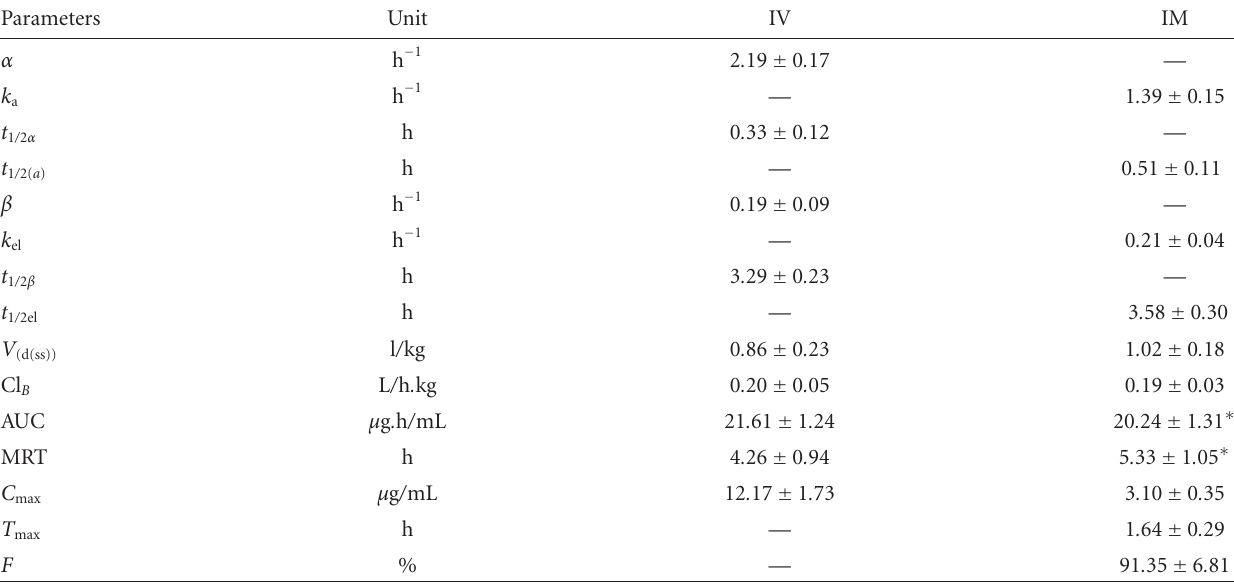
Table 1: Mean ± SD plasma pharmacokinetic parameters of levofloxacin ( μ g/mL) in sheep ( n = 10) following IV and IM administration at a dose rate of 4mg/kg